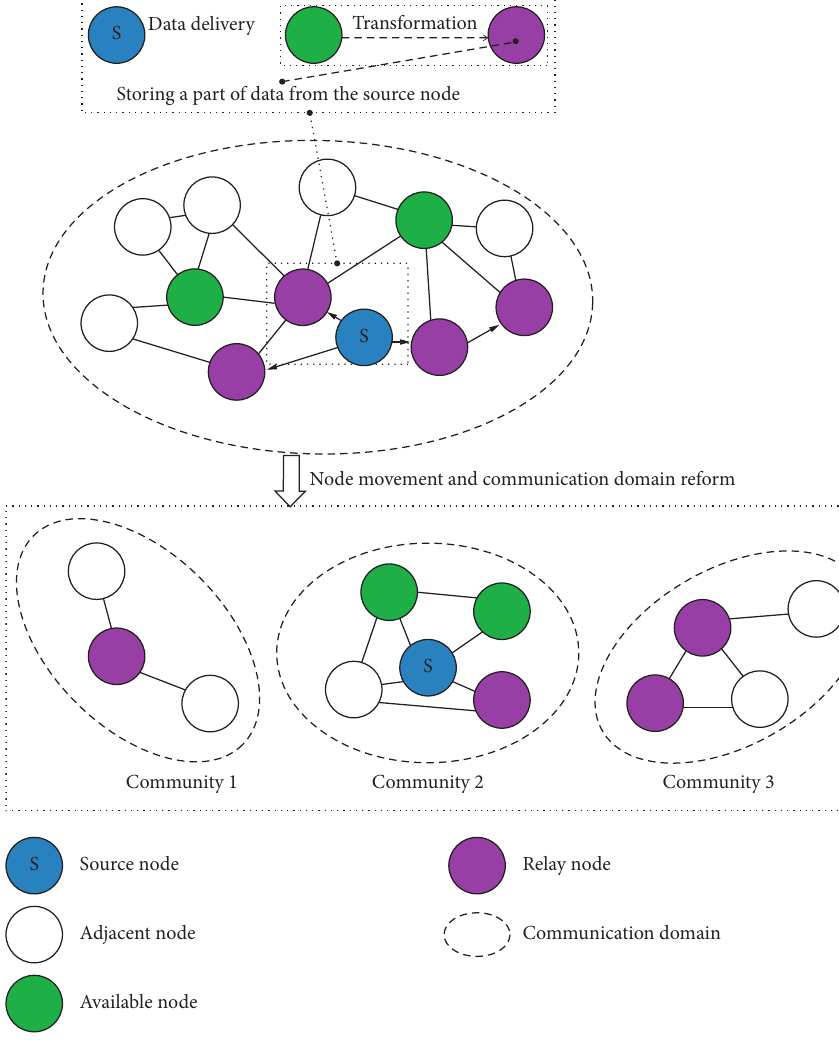
Figure 3: The process of data transmission and communication domain